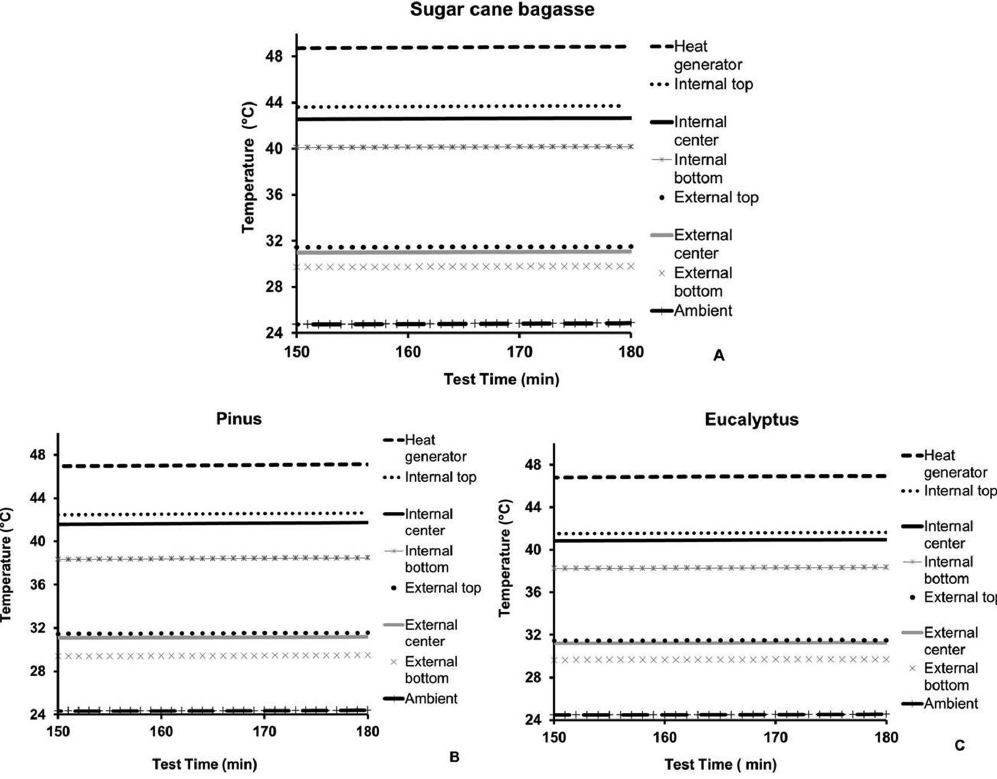
Figure 4. Temperature of the sensors within the last thirty minutes of testing for the species (A) sugar cane bagasse (B) Pinus and (C) Eucalyptus